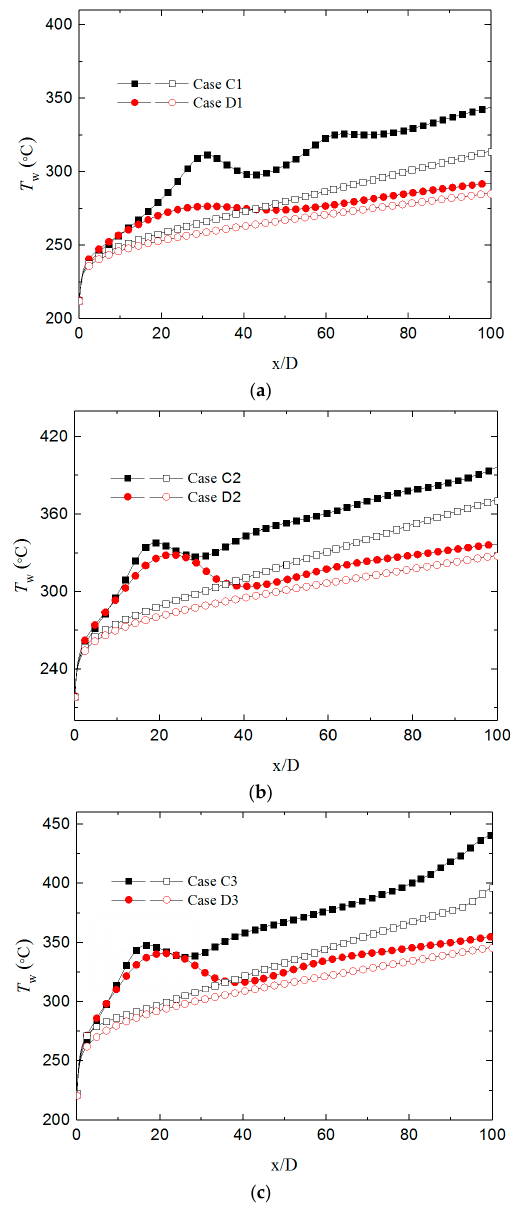
Figure 5. Wall temperature ( α =90°): ( a ) q w = 167 kW/m 2 , ( b ) q w = 253 kW/m 2 , ( c ) q w = 289 kW/m 2 . (Solid: Upward flow; Hollow: Downward flow)